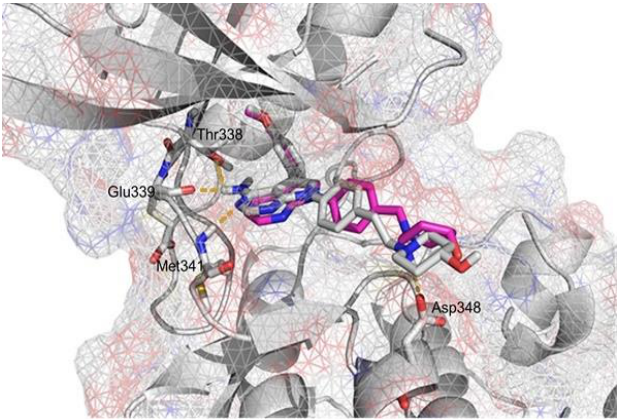
Figure 3. The mix and match strategy applied for the design of NCEs.